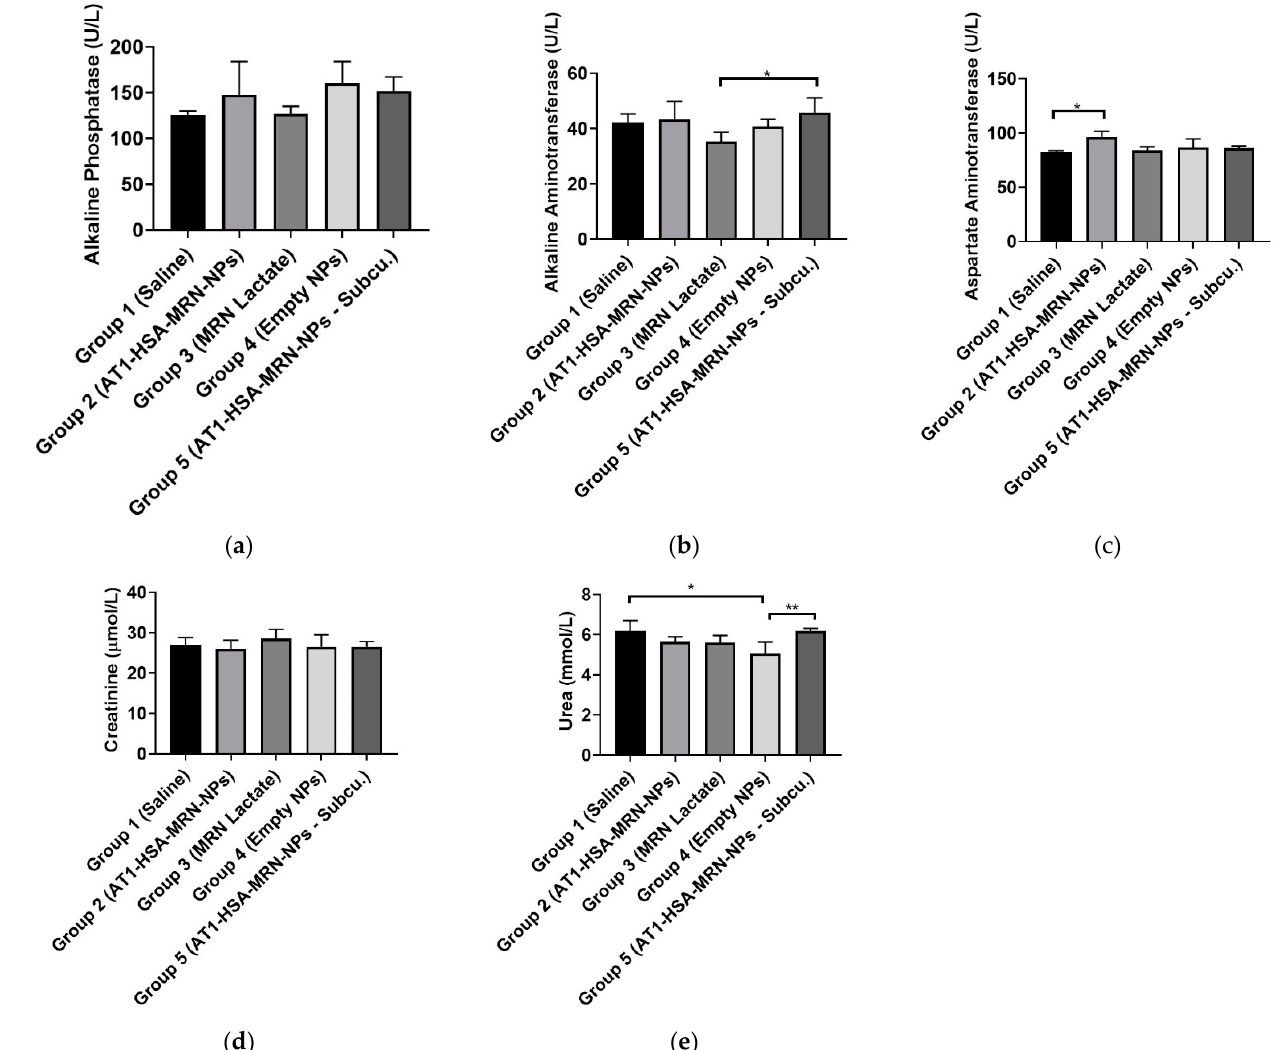
Figure 10. Serum analysis performed as a safety test comparing the ( a ) ALP (U/L); ( b ) ALT (U/L); ( c ) AST (U/L) as liver function tests and ( d ) creatinine ( μ mol/L); ( e ) urea (mmol/L) as kidney function tests. The graph shows a representative result of mean ± SD ( n = 5). ** p < 0.01 , * p < 0.05 were considered significant based on Tukey’s post hoc analysis.